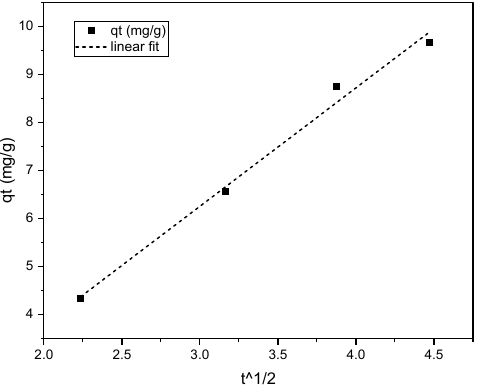
Figure 7. Plot of the intraparticle diffusion model for phenol onto iron supported by carbon foam (75 mg/L of concentration, and 100 mg sorbent) .